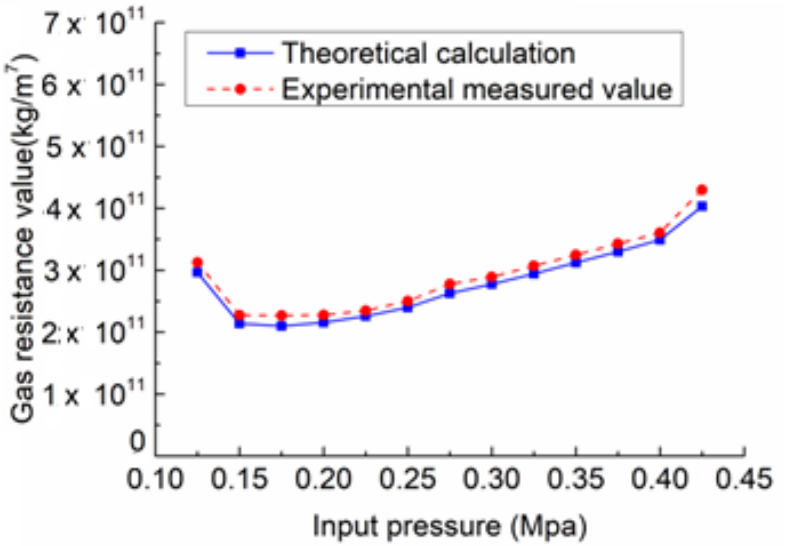
Figure 6. Comparison curve between the theoretical and experimental values of the gas resistance and input pressure of the tube with an inner diameter of 2 mm and length of 0.5 m.